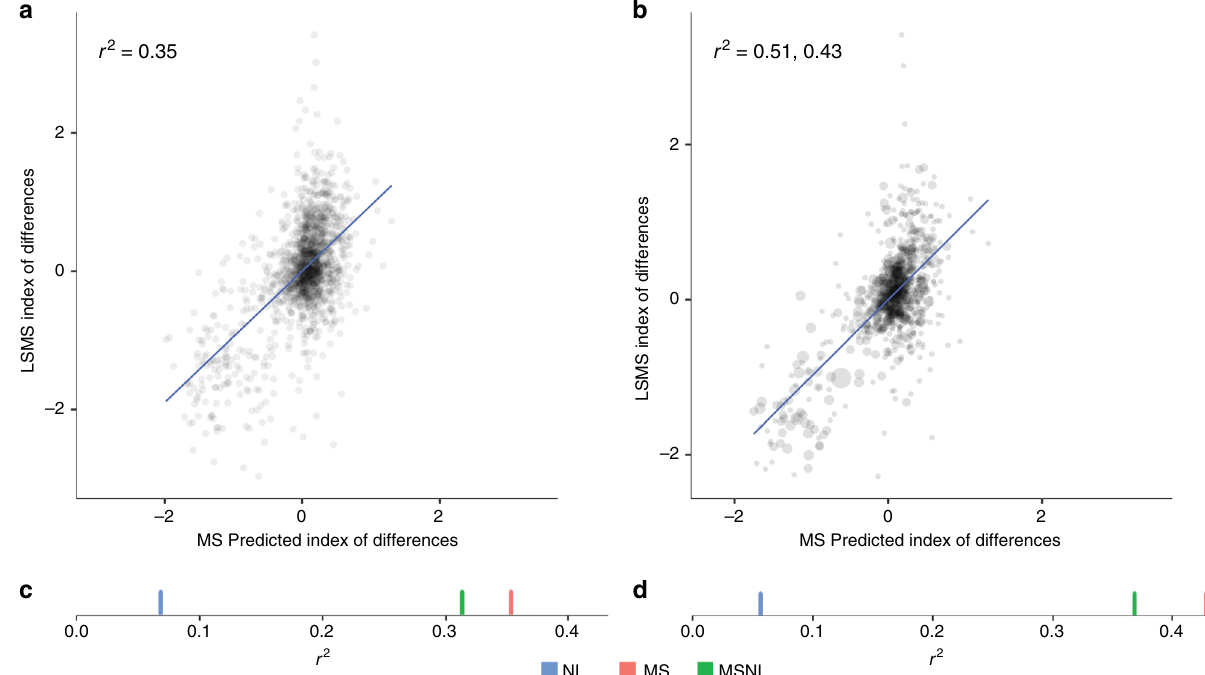
Fig. 4 Satellite predictions of ground-measured changes in wealth over time. a Performance of satellite-based model trained to predict the index of the change in wealth over time at the village level. The index is computed by fi nding the changes in assets at a household level and creating an index of those changes. Plot shows performance of model trained to predict this index of changes at the village level. b Same as a, but with observations aggregated to the district level. Dot size represents number of village observations in each district, and r 2 is reported both weighted ( r 2 = 0.51) and unweighted by number of villages. c , d Cross-validated r 2 of models trained on multispectral (MS, red), nightlights (NL, blue), and both (MSNL, green). Every reported r 2 in c , d is